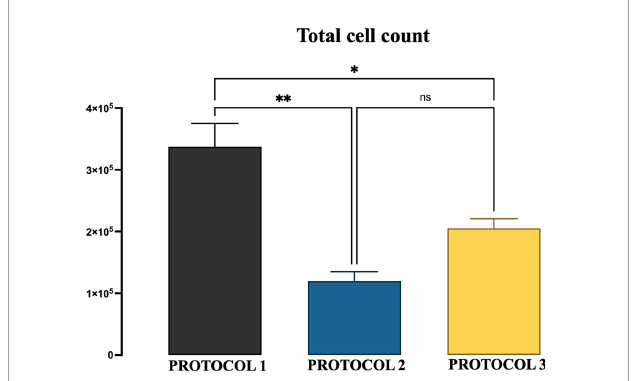
FIGURE2 The yield of microglial cells obtained with three different protocols. The graphs show the group means of the number of microglial cells per mouse brain obtained from 6-month-old mice by the isolation procedure of PROTOCOL 1, PROTOCOL 2, and PROTOCOL 3. For statistical analysis, the one-way ANOVA was used [ F ( 2 , 4 ) = 20.60; p < 0.0078], and a subsequent post-hoc test was carried out using Tukey’s comparison test: ∗ p < 0.05; ∗∗ p < 0.01; N =